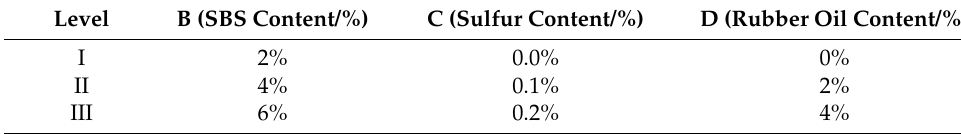
Table 1. Levels of different factors.